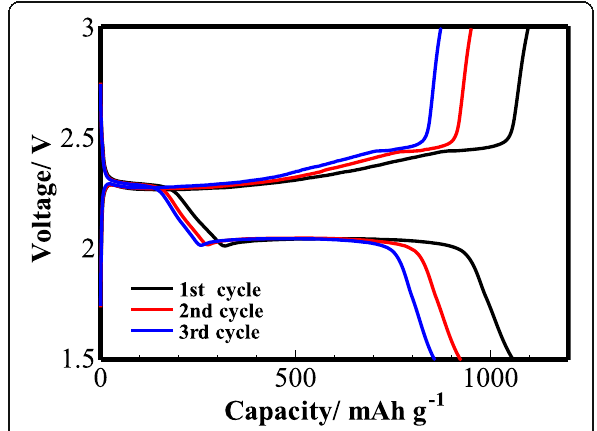
Fig. 10 Long-term cycling stability of the cell with TiO 2 /PC-modified separator at 1